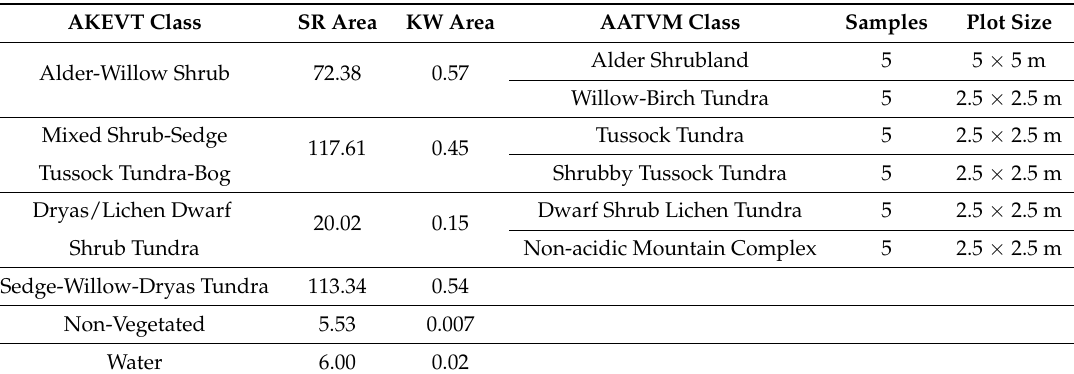
Table 1. Area (km 2 ) of the AKEVT vegetation classes within the study region (SR) and the Kougarok watershed (KW). The crosswalk between AKEVT and AATVM types, number of plots within each vegetation type, and the size of field plots by vegetation type are also presented. Field samples were not collected for Sedge-Willow-Dryas Tundra, Non-Vegetated, and Water